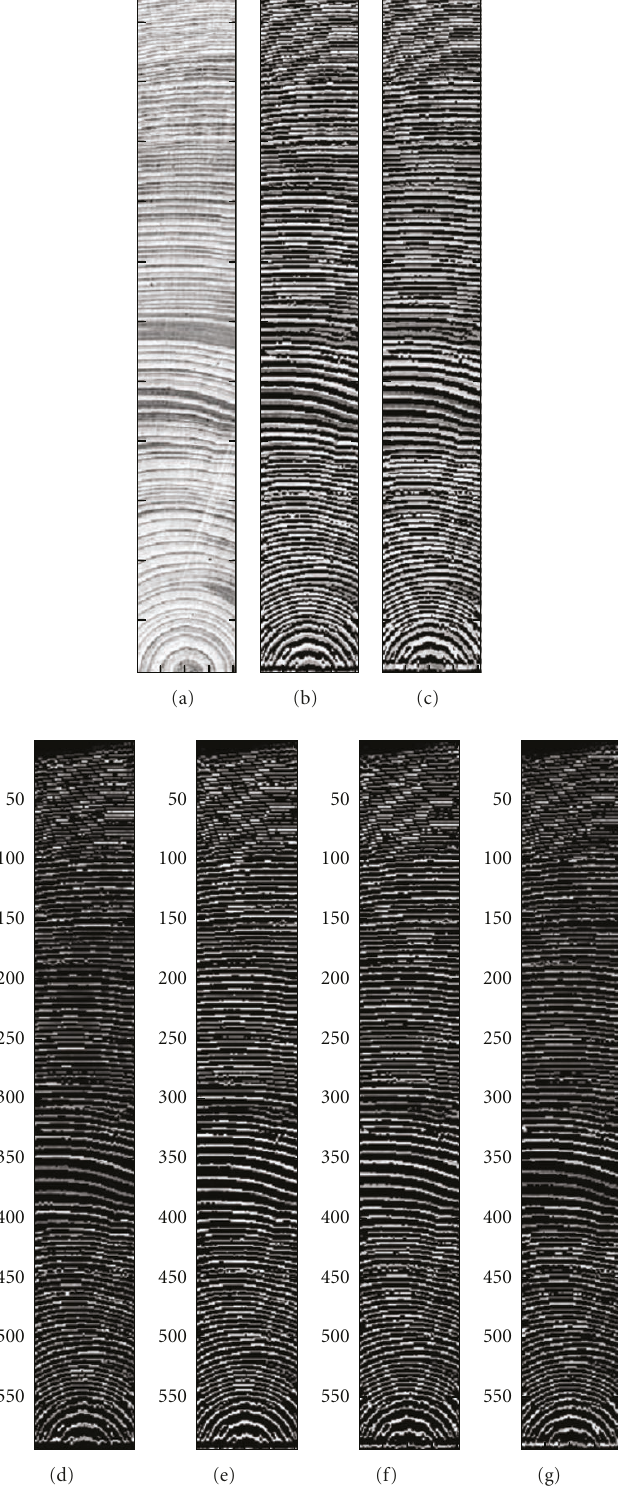
Figure 16: Tree growth estimates for spruce sample using variable frequency spacing filterbank (sample 12 from Grissino-Mayer database). (a)Original image, (b) first-half season,and (c) second-half season.Quarterly growth estimates: (d) 1st, (e) 2nd, (f) 3rd, and (g) 4th quarters. The images show excellent reconstructions with few